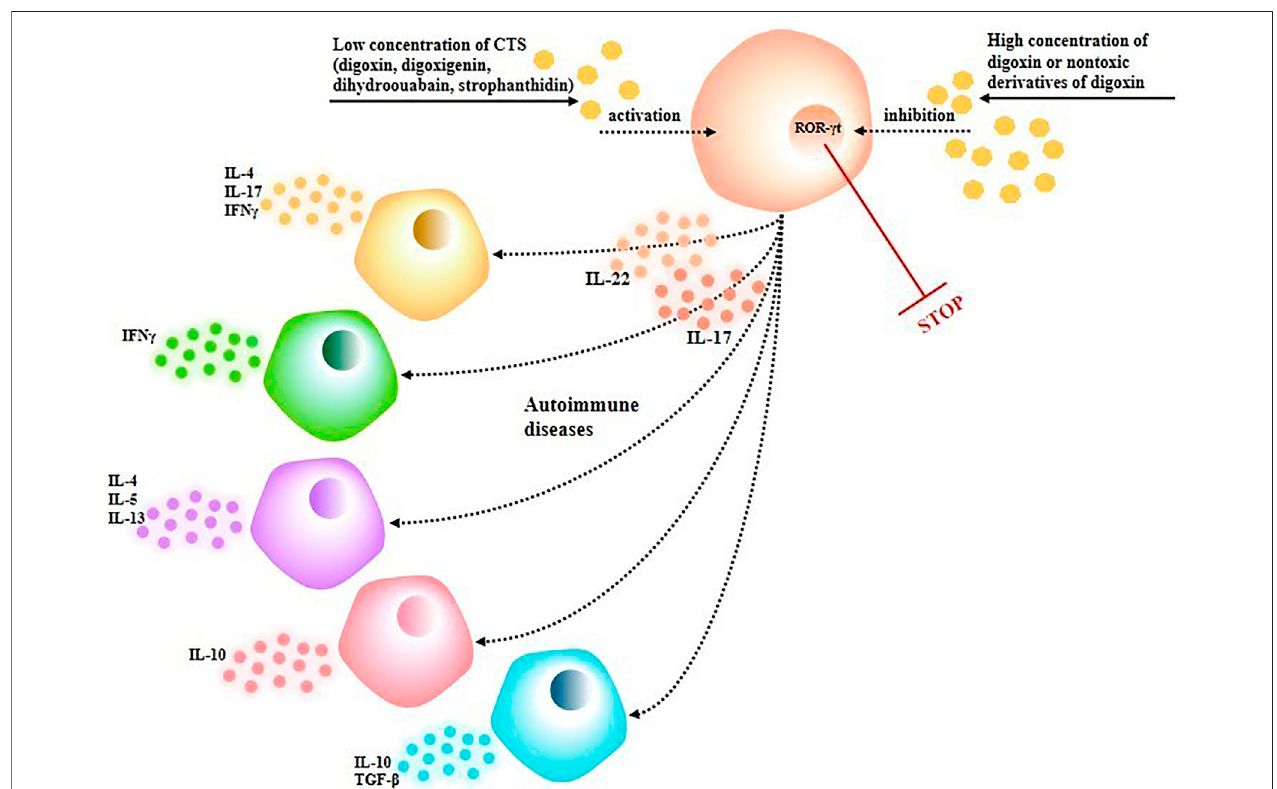
FIGURE 6 | Effects of different concentrations of CTS on the cellular immune